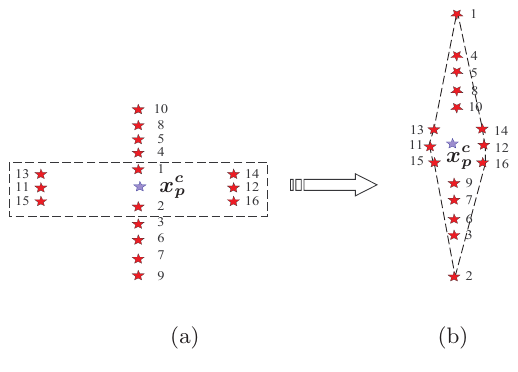
Fig. 10. Neighborhood determination by convex